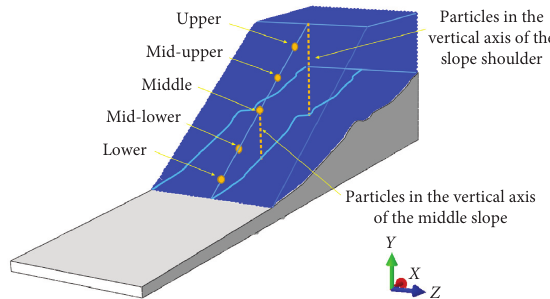
Figure 14: Location of monitored